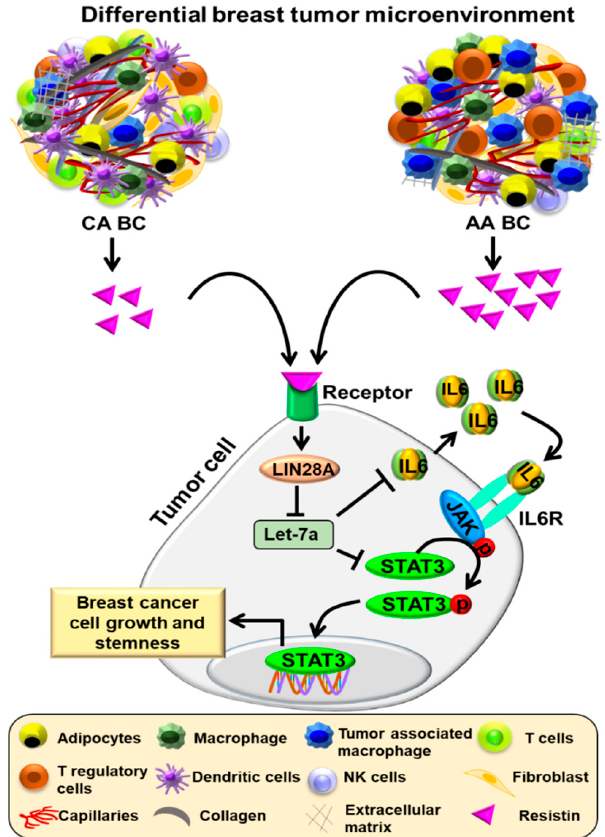
Figure 6. A schematic showing Let7a-mediated effects of resistin in breast cancer cells. Racially disparate tumor microenvironment in breast tumors leads to the release of higher levels of resistin in African American BC patients than CA patients. Resistin increases the expression of LIN28A, which then represses the maturation of Let-7a miRNA leading to enhanced expression of IL-6 and STAT3/pSTAT3. Activated STAT3 alters the expression of genes associated with the growth and stemness potential of BC cells.